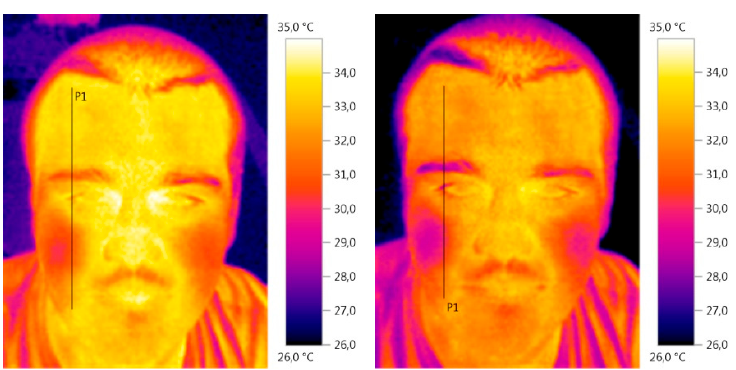
Figure 2. Skin temperature on the right side of the face ( left ) 32.7 °C average temperature along the line without air jet; ( right ) 31.4 °C average temperature along the line with air jet).